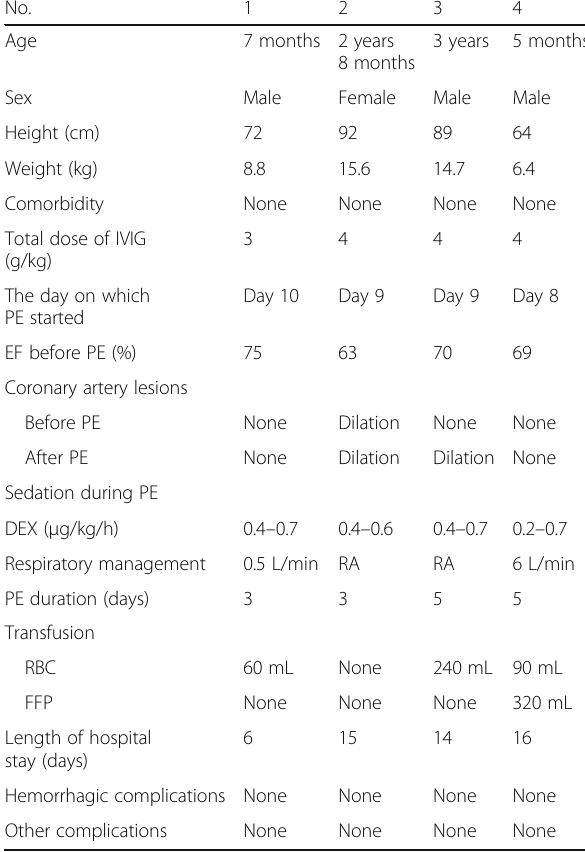
Table 1 Patient demographics and management of